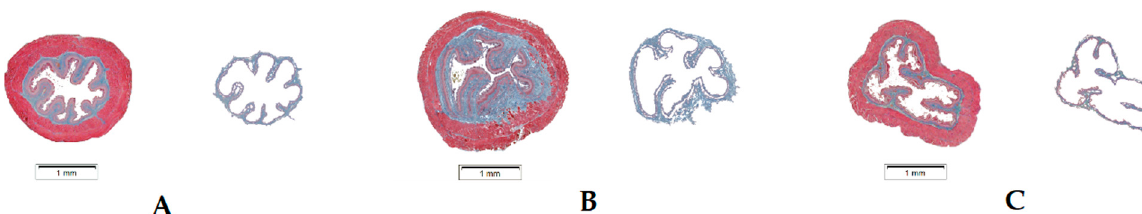
Figure 2. Masson’s trichrome stain was used for fibrosis determination. Healthy rat; rat with corrosive burn but without TGF- β 1 inhibitor treatment (control); rat with corrosive burn and with TGF- β 1 inhibitor treatment (treatment) (( A – C ), respectively). The fibrosis area ratio was significantly lower in the treatment group than that in the control group ( p = 0.001).